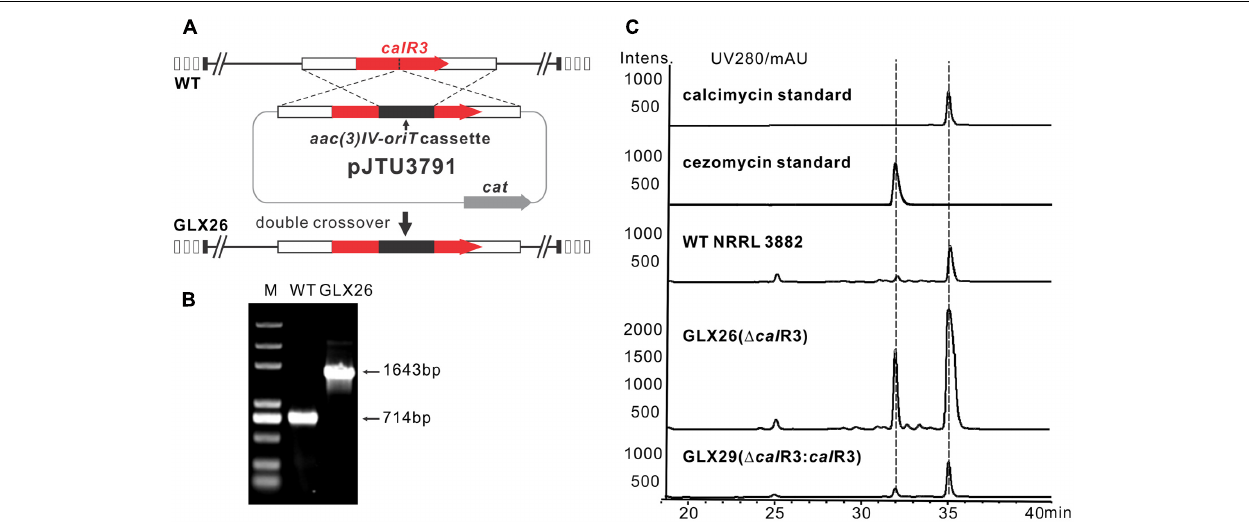
FIGURE 2 | Construction and analysis of calR3 mutant strain. (A) A scheme showing the disruption of calR3 by the apramycin resistance gene cassette aac(3)IV to generate the mutant GLX26. (B) The success of construction was confirmed by PCR amplification. For the wild-type gene, the PCR product is 714 bp, while for the mutant, the PCR product is 1,643 bp. (C) HPLC traces showing that the inactivation of calR3 leads to the improvement of calcimycin and cezomycin. The production of calcimycin and cezomycin was restored in the calR3 complemented strain GLX29.